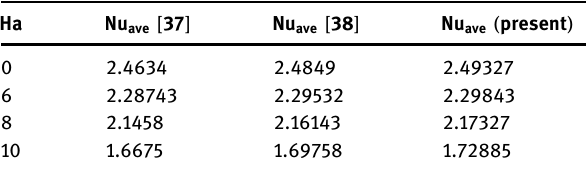
Table 2: Validation of current and published fi ndings with common